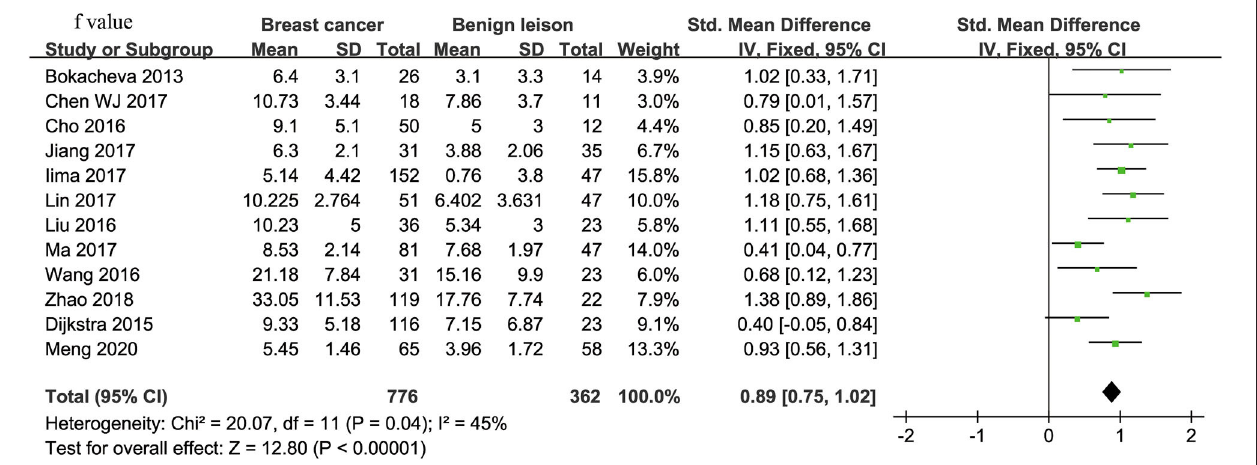
FIGURE 6 | Forest plot of the mean value of perfusion fraction (f) between malignant and benign breast lesions. The standardized mean differences (SMDs) indicated that breast cancers had a significantly higher f value than did benign